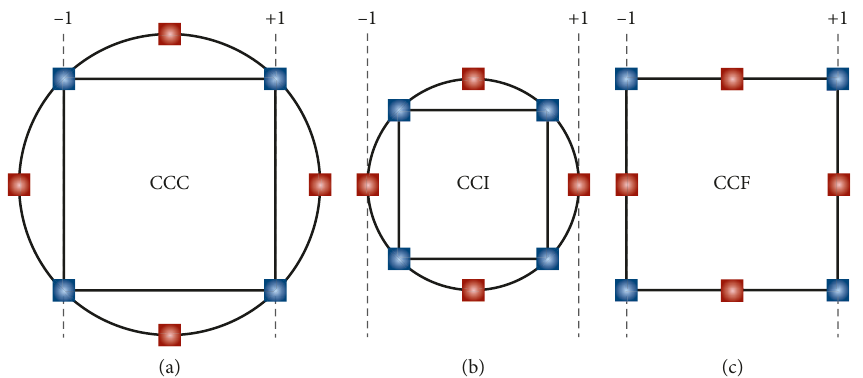
Figure 1: Star points locations in three types of CCD plans [20]: (a) circumscribed; (b) inscribed; (c) face-centered.